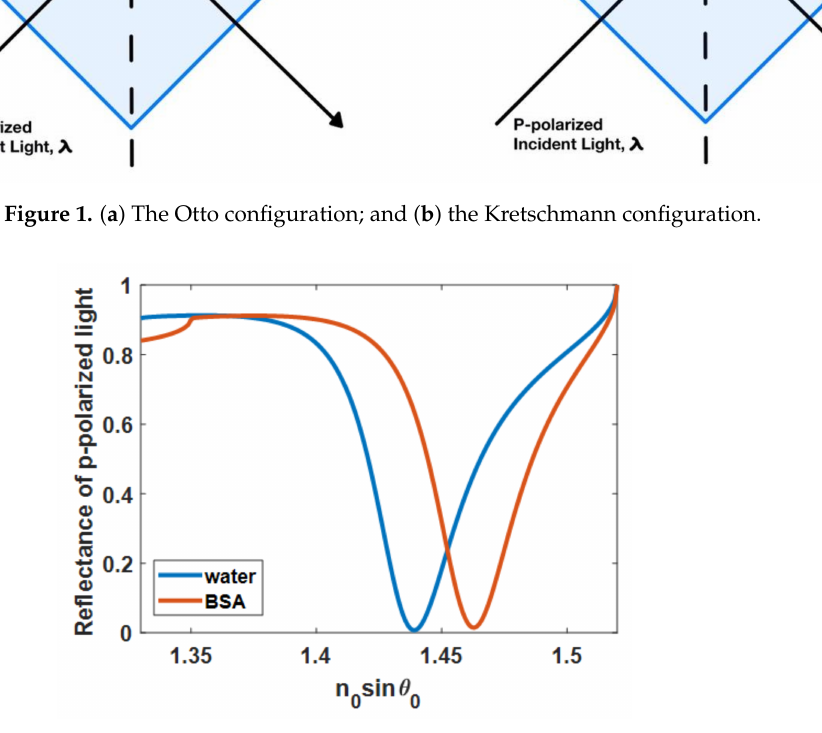
Figure 2. Reflectance spectra of uniform 50 nm gold on BK7 glass substrate when the gold sensor was illuminated by p-polarized coherent light at 633 nm. The blue curve showed the reflectance spectrum when the sample sensing region was water, and the red curve showed the reflectance spectrum when the sample sensing region was BSA protein solution with a sample refractive index of